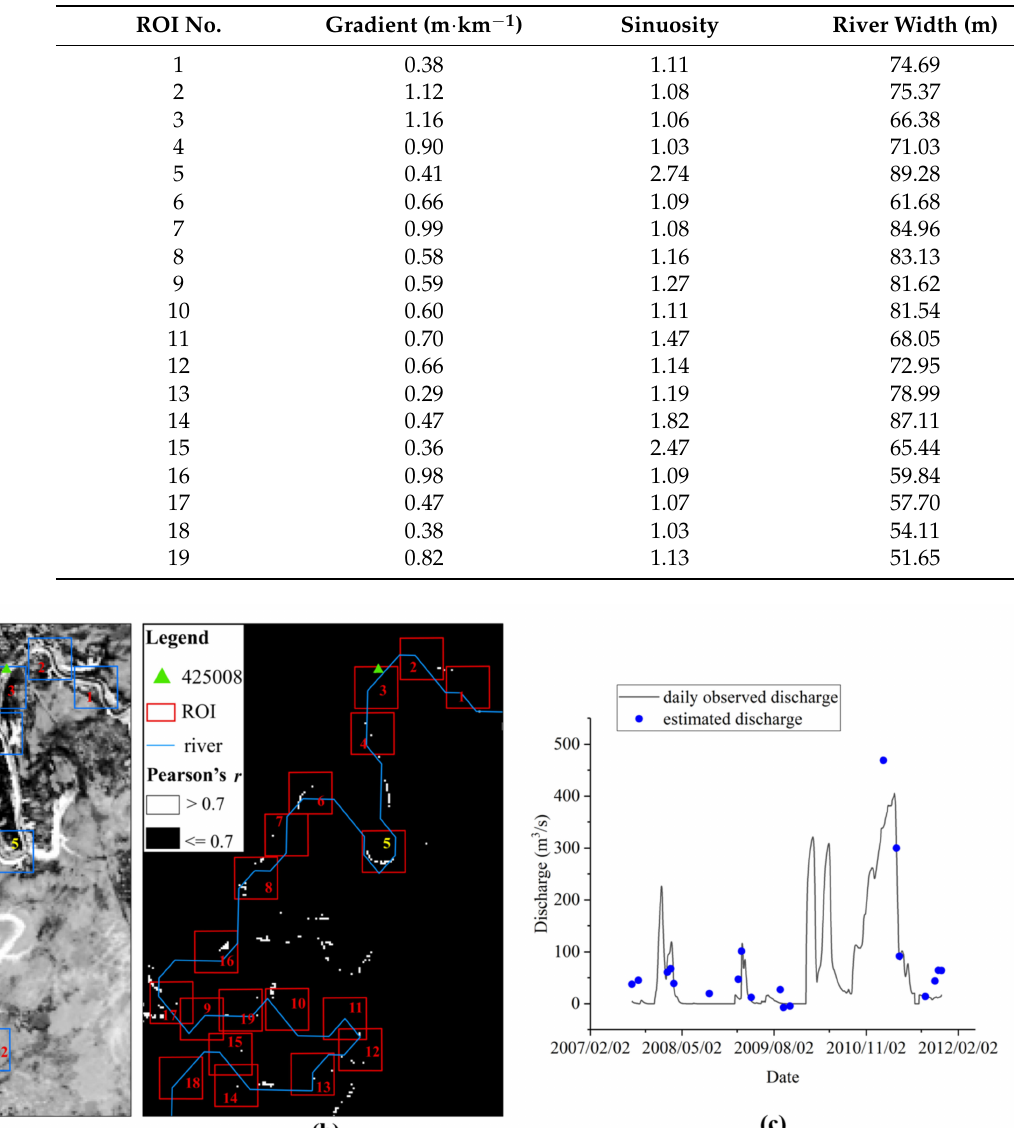
Table 5. Gradient, sinuosity, and width of the 19 ROIs.